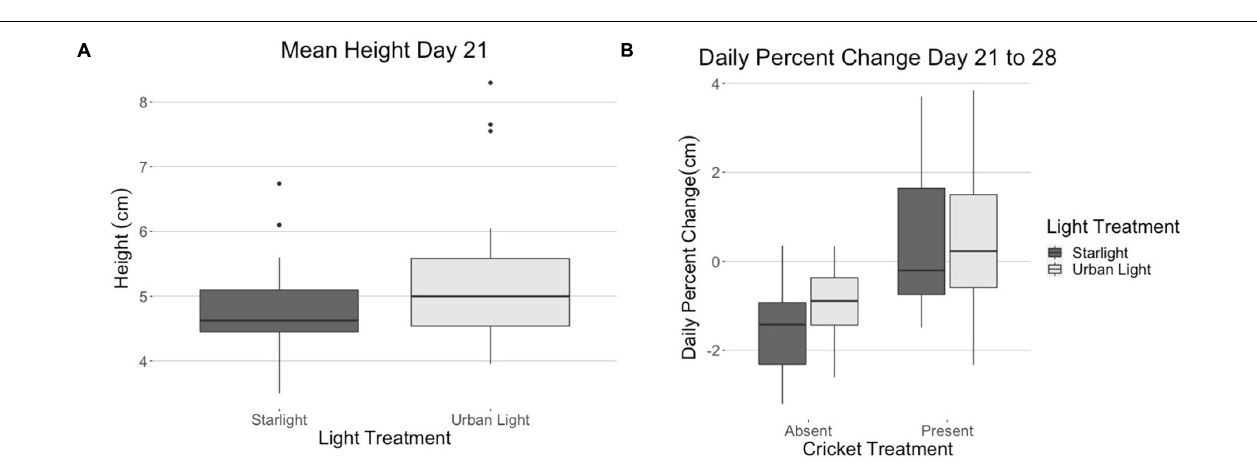
FIGURE 3 | (A) Bluegrass height at day 21 separated by light treatment when no crickets were present. Grass in urban light was taller than grass in starlight conditions. (B) Daily percent change in height of grass (change from day 21 to day 28 divided by the number of days in the chamber) separated by light treatment. There was no difference in daily percent change across light or cricket